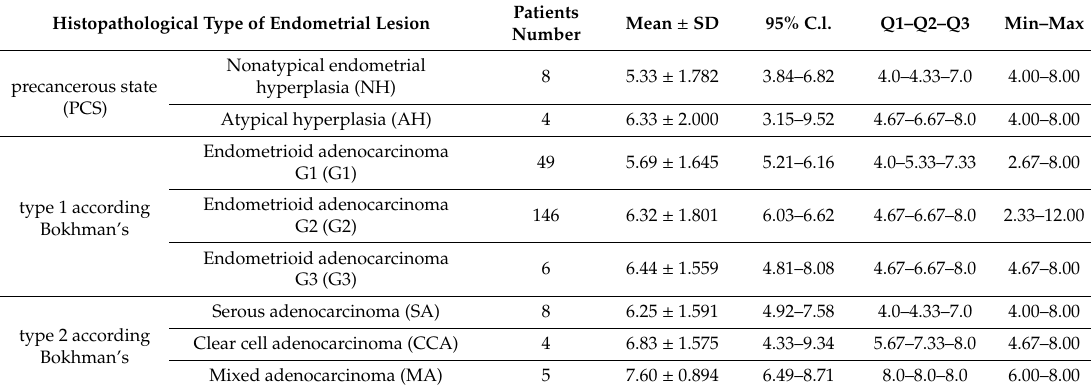
Figure 3. Mean AMHRII expression: ( a ) due to years of hormonal activity (r s = 0.053, n = 230, p = 0.426); ( b ) in a group of patients without and with arterial hypertension (Mann–Whitney U test: Z = 0.227, p = 0.821); ( c ) due to hormonal status: premenopausal ( p ), perimenopausal (o), and postmenopausal (m) women (Kruskal–Wallis test: H (2, N = 230) = 1.248, p = 0.536); ( d ) depending on the number of birth (r s = 0.033, n = 230, p = 0.624). Table 1. Summary of the histopathological type of endometrial lesion, number of patients in each group, and mean ± SD, 95% confident limits of mean, quartiles Q1, Q2, Q3, minimal and maximal values of AMHRII